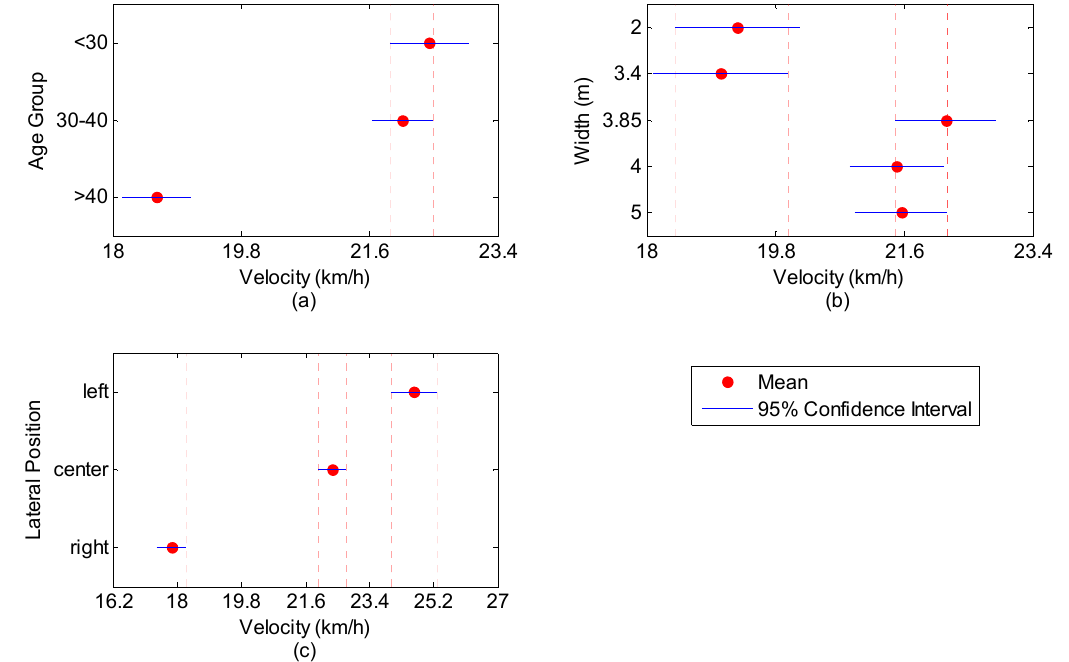
Figure 4. Multi-comparison Results for Velocities under ( a ) Di ff erent Age Groups, ( b ) Lane Widths and Figure 4. Multi ‐ comparison Results for Velocities under ( a ) Different Age Groups, ( b ) Lane Widths ( c ) Horizontal and ( c ) Horizontal Positions.